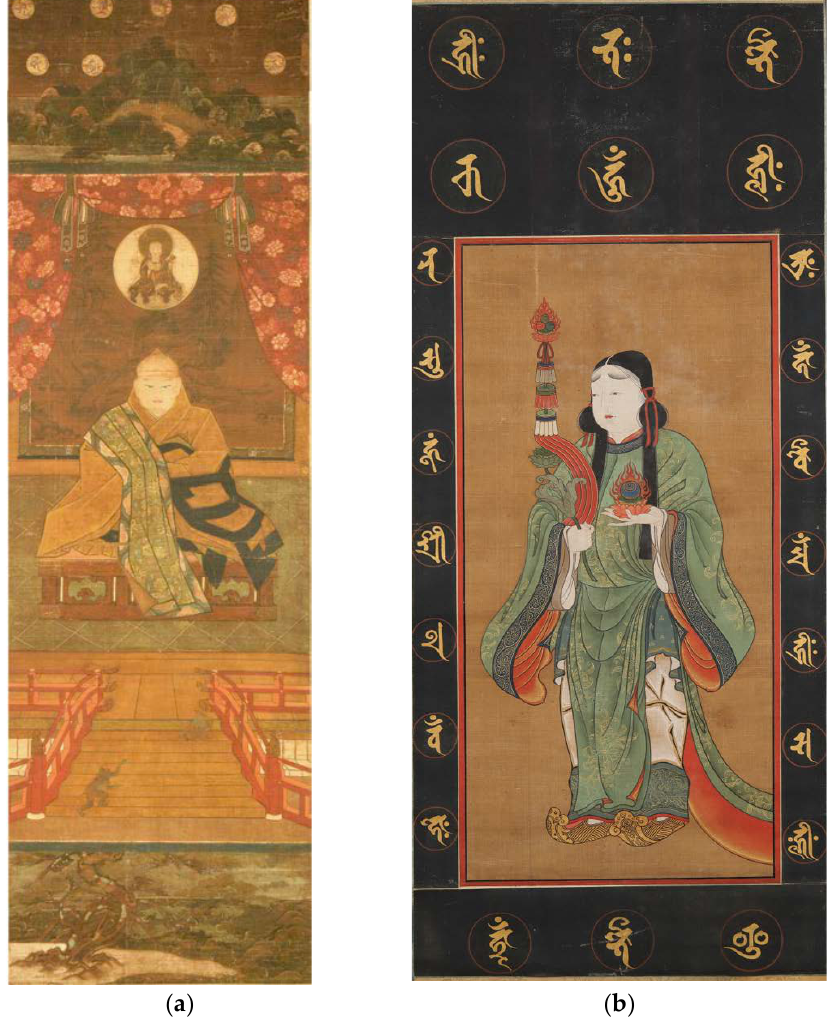
Figure 2. ( a ) Hie Sannō Jūzenji mandala , Kamakura period (1185–1333), hanging scroll, color on silk. Shinnyo-en temple, Tachikawa, Tokyo; Reproduced with permission from (Faure 2016b). Copyright 2016 University of Hawai’i Press. ( b ) Jūzenji bījā (seed -syllable) mandala , Muromachi period (1336 – 1573), hanging scroll, color on silk. Kannon- ji temple, held at Biwako Bunkakan, Shiga prefecture. Another mandala from Kannon- ji temple , held at Biwako Bunkakan in Shiga, ( Figure 2b) is designed in more conspicuous Buddhist contours. The image portrays Jūzenji in his